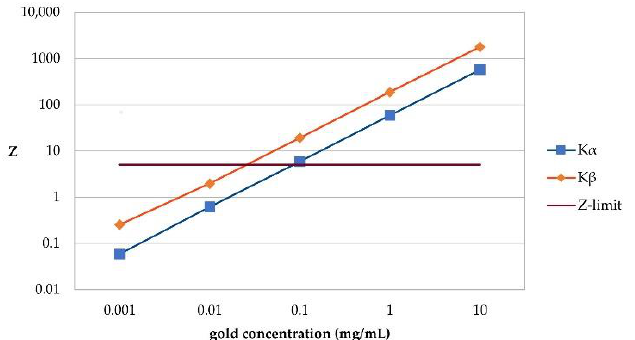
Figure 7. Signal significance ( Z ) per gold concentration in abdominal prescan. Significance for both K α and K β after application of spatial filtering algorithm is shown. Z-limit of 5 like in scan of thorax indicates at which significance a signal could still be detected and is set based on preliminary studies of our research group. Therefore, its crossing point with K α and K β marks lowest detectable gold concentration for each, respectively. Like in thorax, filtering for K β results in higher significance than for K α . This results from higher efficacy of our spatial filtering algorithm for K β -signal region, as background there mostly derives from single Compton scattered photons.